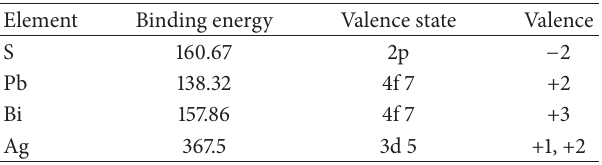
Table2:ValencestateparametersofelementsinPbS,Bi-doped-PbS, and Ag-doped-PbS